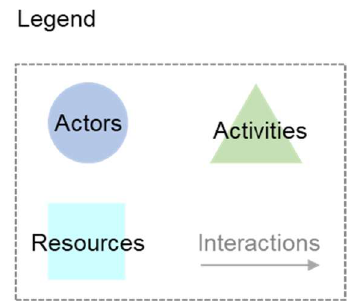
Fig. A3.1. Individual mental models of the leaders of six fishing cooperatives